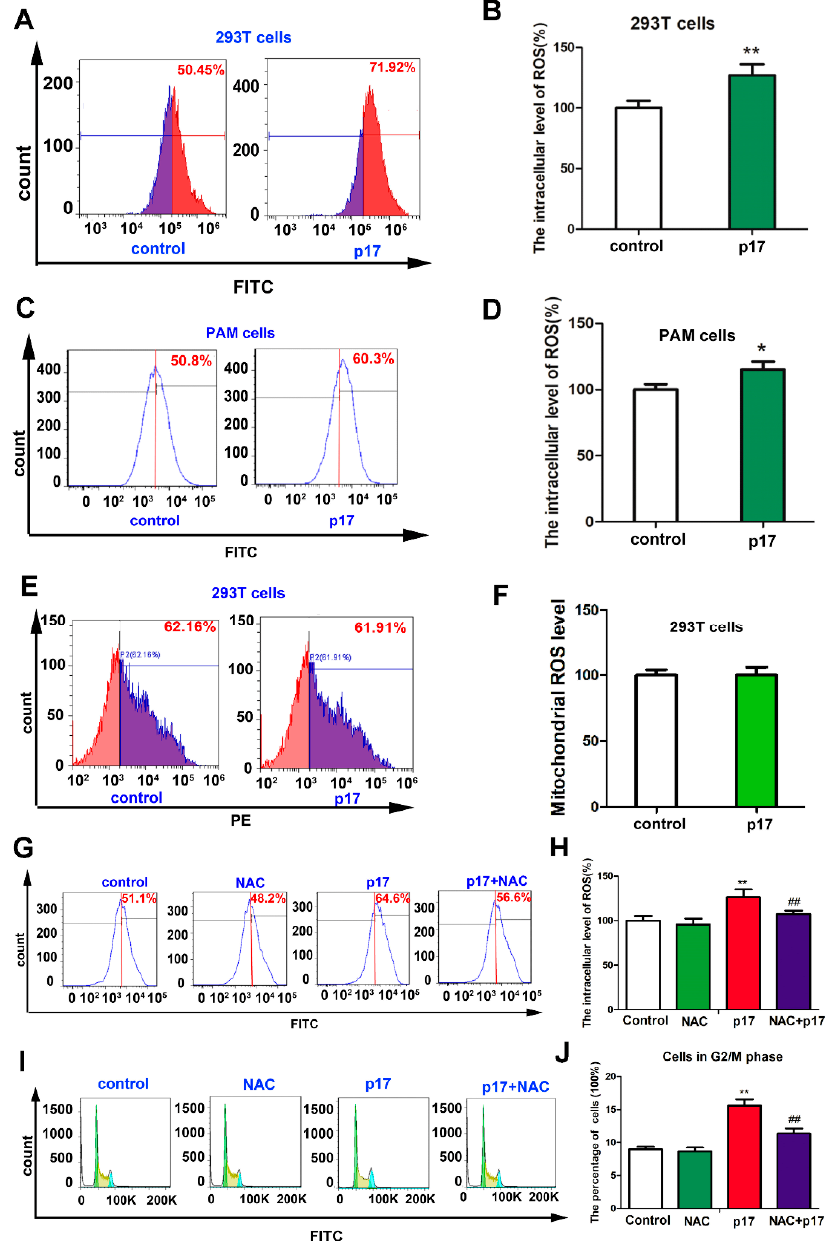
Figure 3. P17 could induce the production of ROS, and the intracellular ROS was involved in the process of p17-induced cell cycle arrest. ( A – D ) p17 induced the overproduction of intracellular ROS in 293T and PAM cells. After cells were transfected with FLAG-p17 (1 µg/mL) plasmids for 24 h, the cells were collected and the intracellular ROS level was analyzed with 2’,7’-dichlorofluorescin diacetate staining followed by flow cytometry. ( E , F ) The effect of p17 on the mitochondrial level of ROS in 293T cells. After cells were transfected with FLAG-p17 (1 µg/mL) plasmids for 24 h, the mitochondrial level of ROS was analyzed using a mitoSOX red mitochondrial superoxide indicator followed by flow cytometry. ( G , H ) NAC could alleviate the overproduction of ROS induced by p17. 293T cells were pretreated with NAC (2.5 mM) for 30 min, and then transfected with p17 gene plasmid in the presence of NAC for another 24 h. ( I , J ) NAC (2.5 mM) could partly reverse the cell cycle arrest induced by p17. Control groups were transfected with empty plasmids; * p < 0.05, ** p < 0.01 versus control groups; ## p < 0.01 versus p17